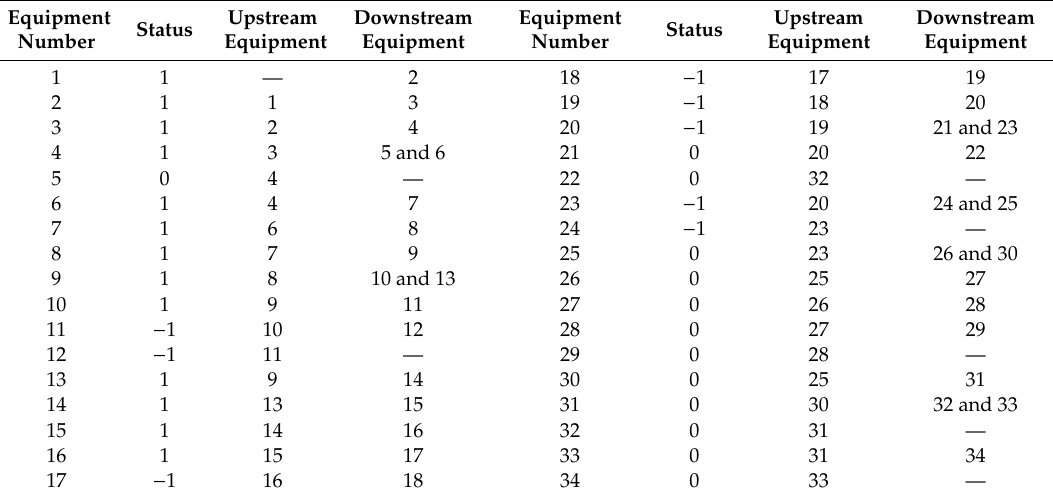
Table 6. The line list of Figure